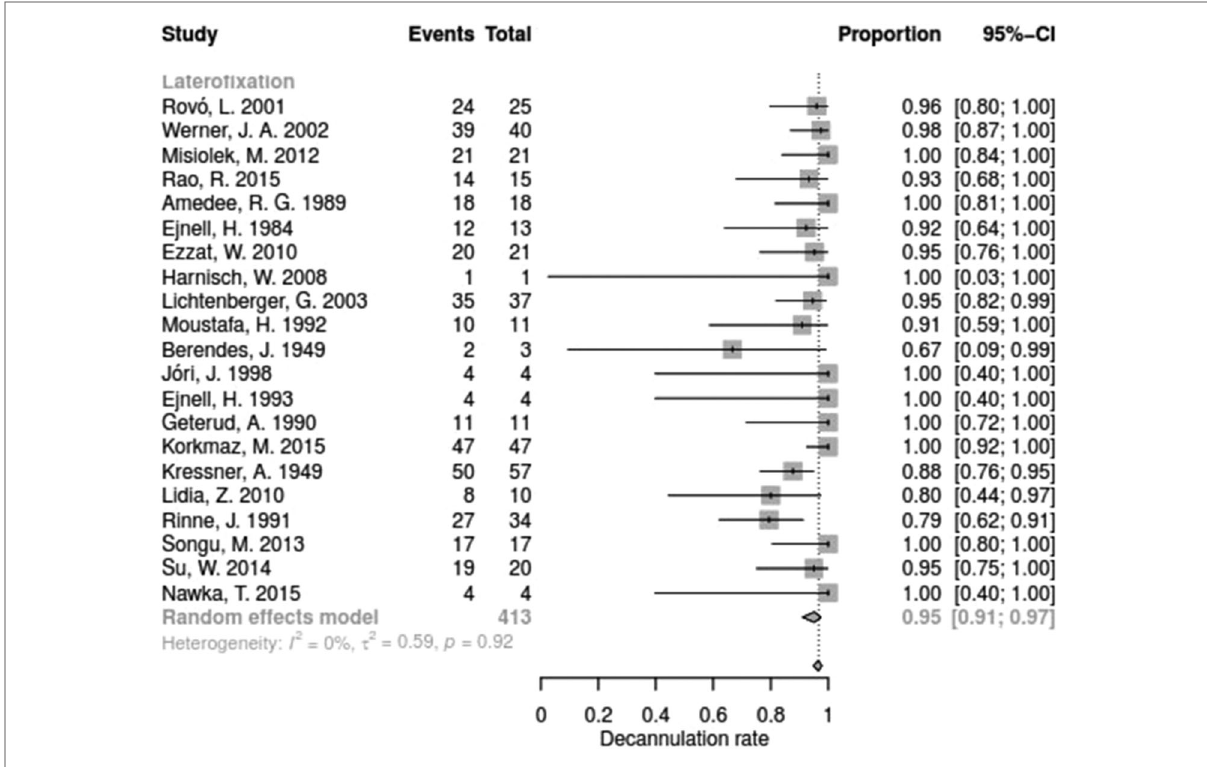
FIGURE 5 Forest plot of decannulation rates in studies on latero fi